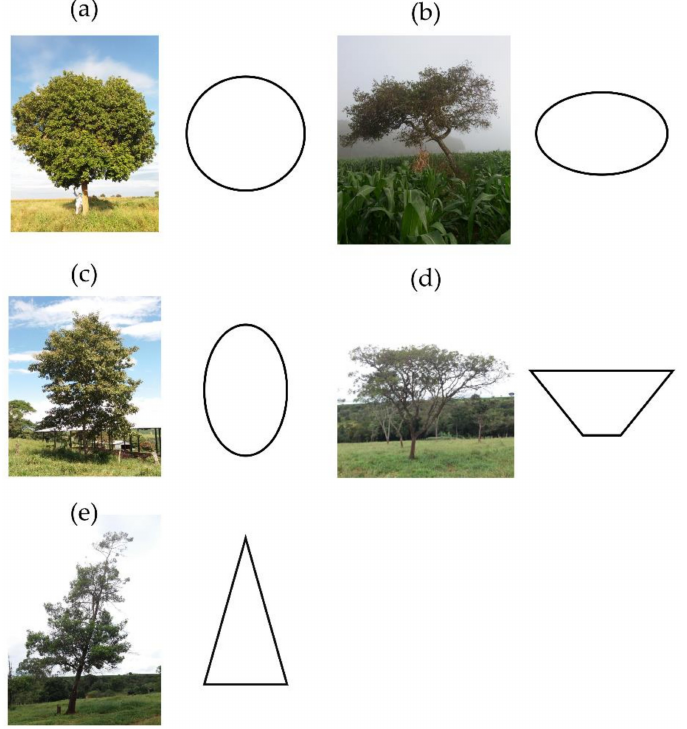
Figure 3. Classification of tree crown geometric shapes (CGS): circular— Eriotheca gracilipes (K. Schum.) A. Robyns ( a ), elliptic— Hancornia speciosa Gomes ( b ), columnar— Zeyheria tuberculosa (Vell.) Bureau ex Verl. ( c ), umbelliform— Leptolobium elegans Vogel ( d ), and pyramidal— Myrsine gardneriana A. DC. ( e